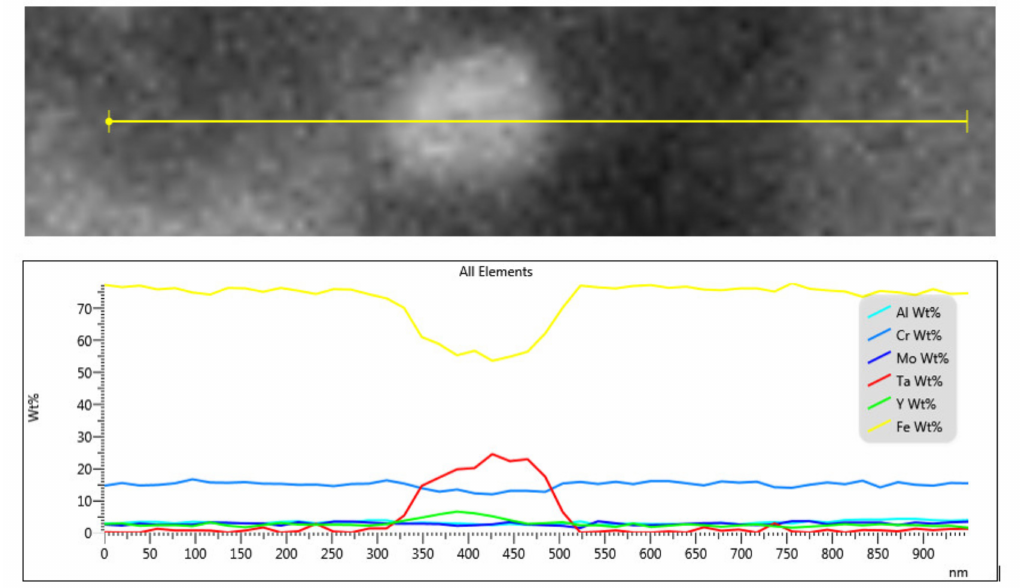
Figure 5. EDS line scan analysis of a precipitate in the microstructure of the OPH1 steel (as-rolled state, without heat treatment, EHT—10 kV, WD—6.4 mm).